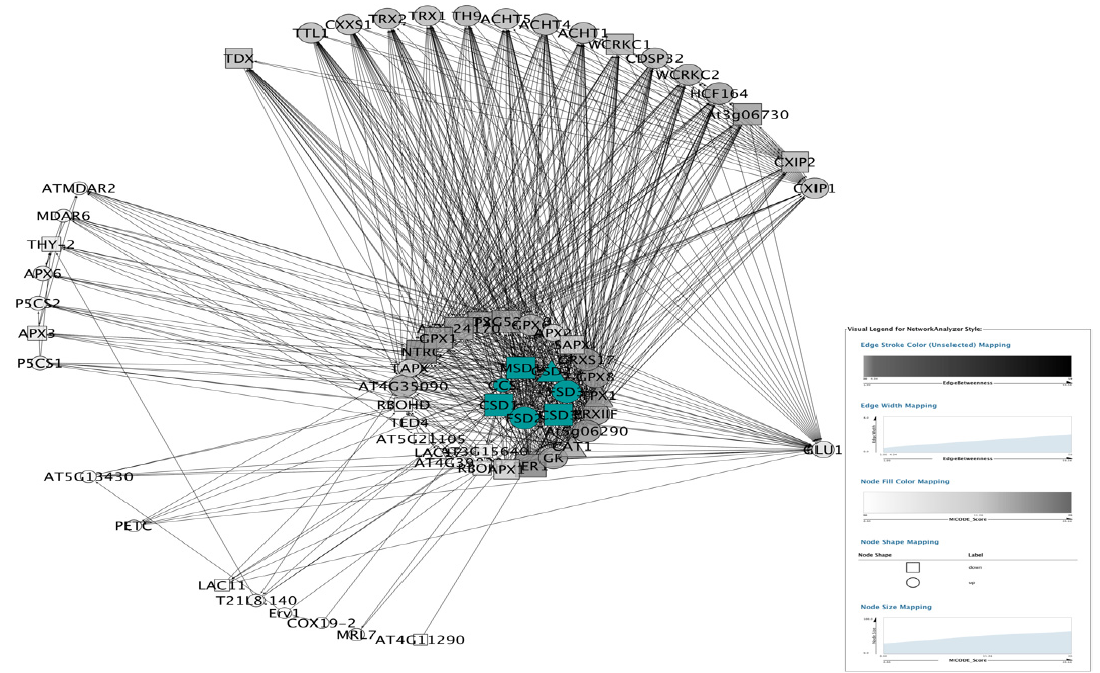
Figure 6. The first-neighbors of SODs PPI sub-networks induced by trypsin were constructed by cytoscape software. Nodes were arranged as attribute circle layout according to the neighborhood connectivity of selected